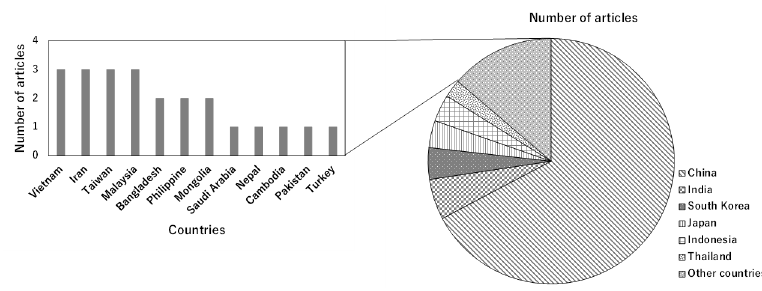
Figure 4. Spatial distribution of research articles on MPs .